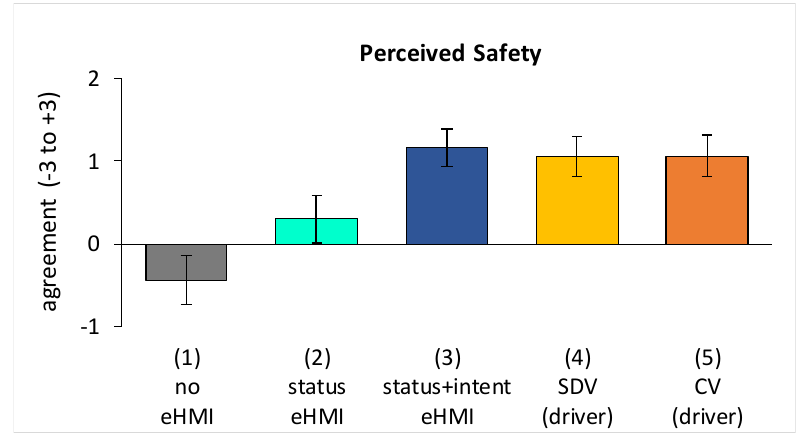
Figure 9. Mean perceived safety scores for all yielding test conditions. Error bars: ±1 SE.